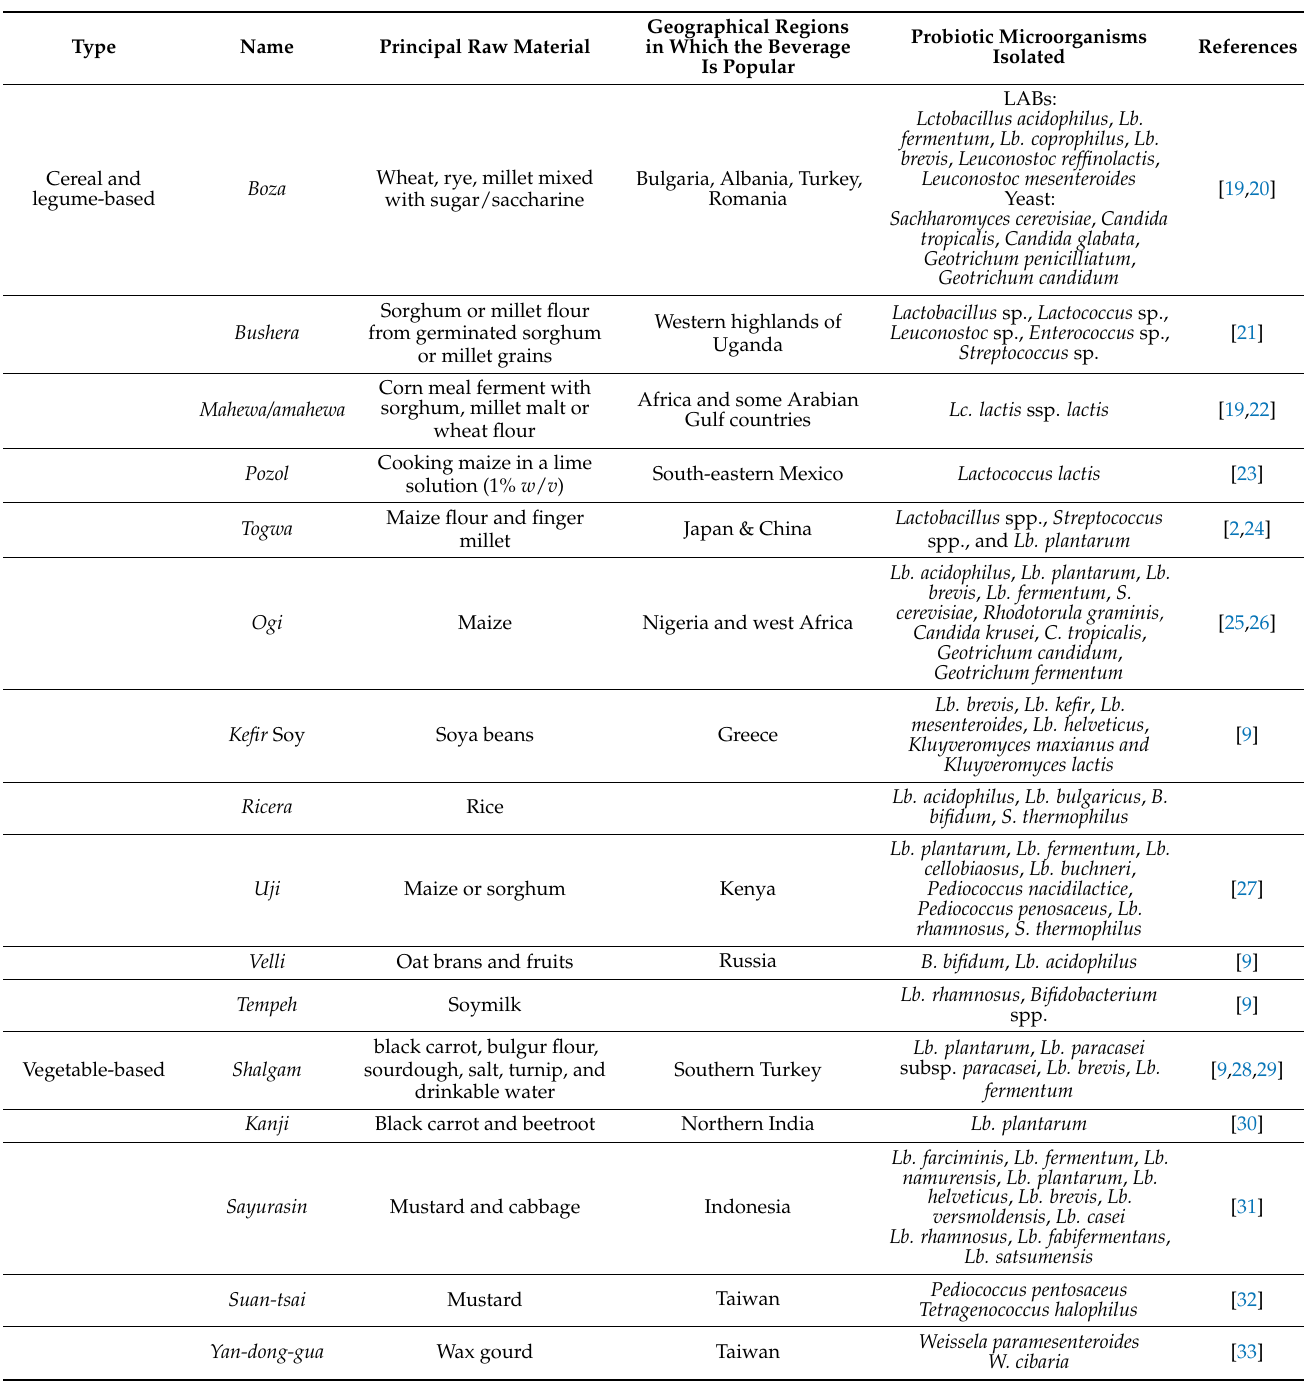
Table 1. Different traditional non-dairy probiotic beverages, their principal raw materials and probiotic microorganisms involved in